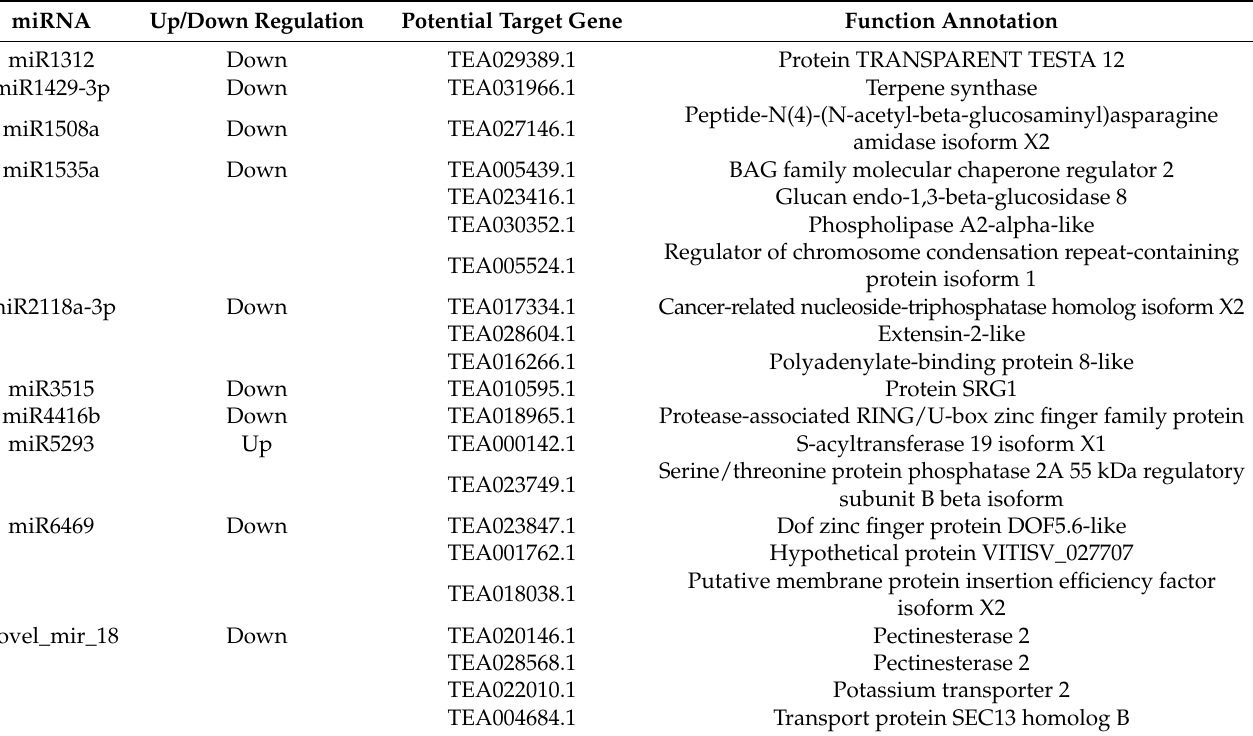
Table 1. Co-regulated DEMs in LT/CK and NO/CK involved in NO signaling pathway under low-temperature.